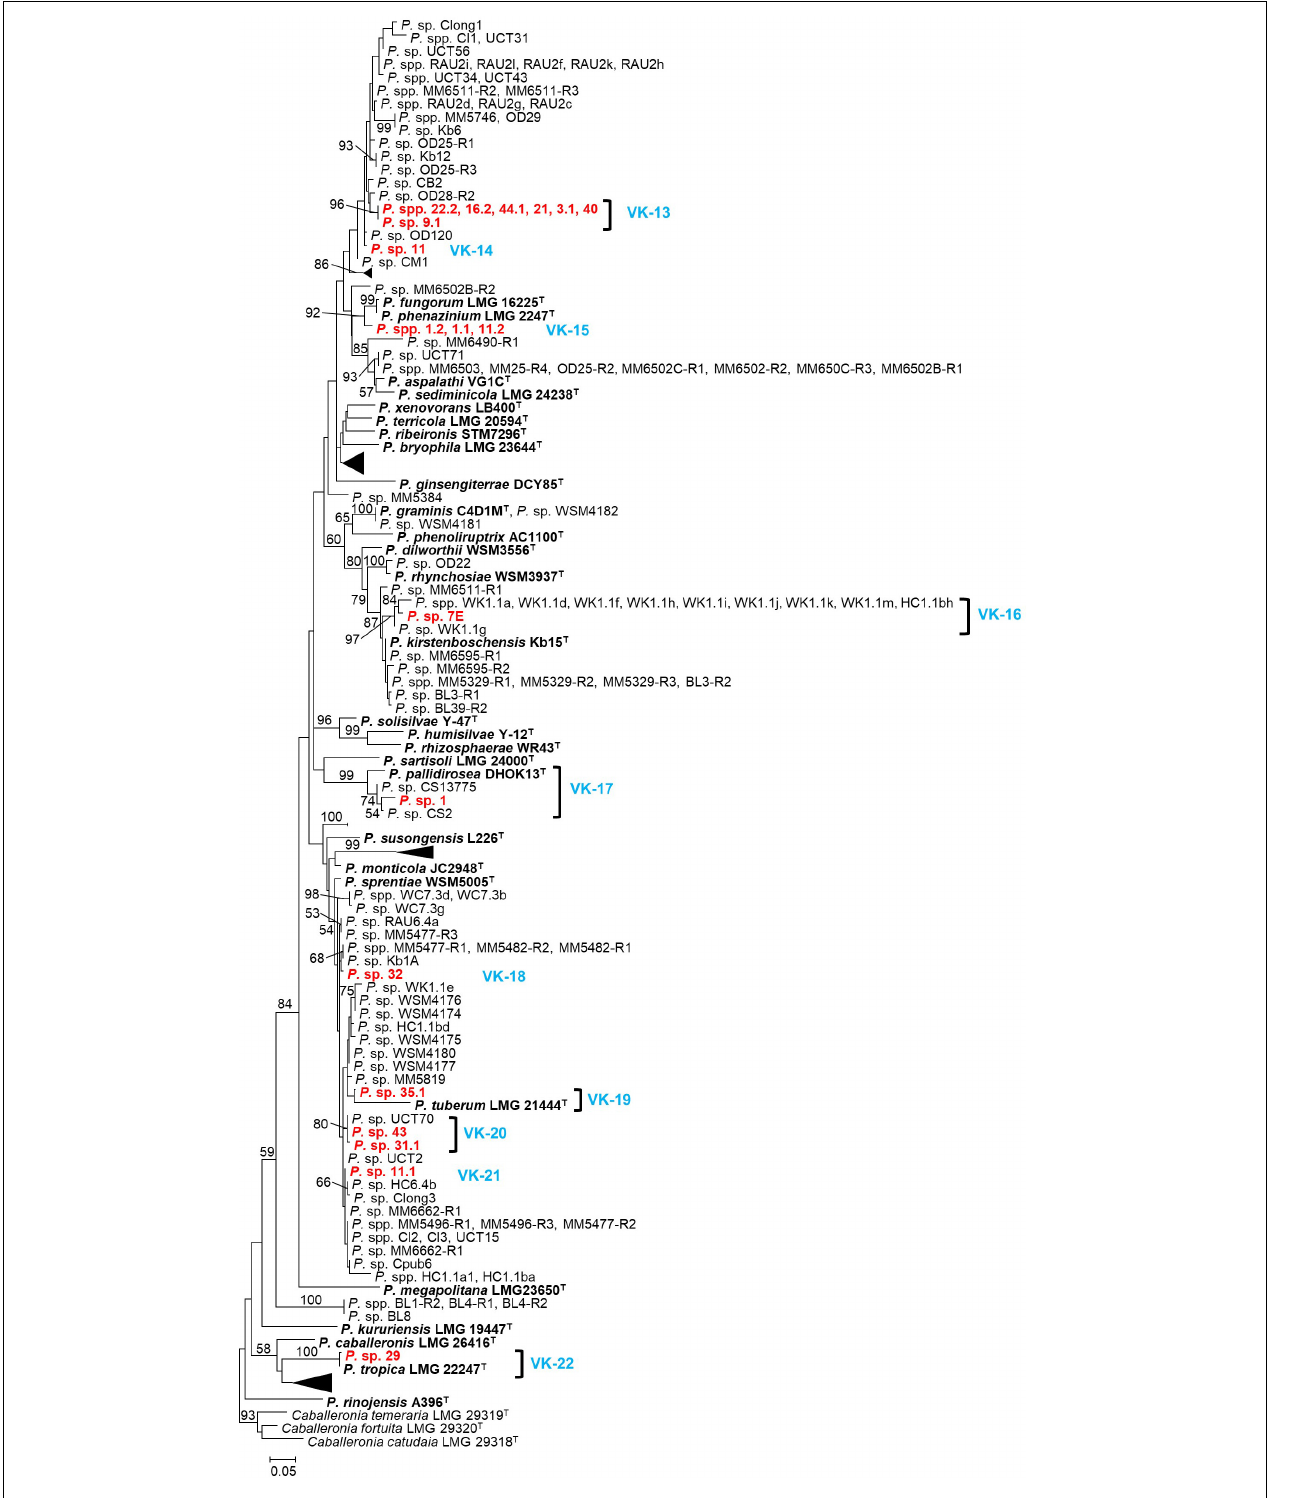
FIGURE 2 | A maximum-likelihood phylogeny of the recA locus for the beta-rhizobial genus Paraburkholderia . Isolates from this study are listed in red, while type strains of species appear in bold. The delineated Vachellia karroo -associated lineages (VK-13 to VK-22) appear in blue. In order to minimize the phylogeny some lineages (which do not contain any isolates from this study), have been collapsed. The expanded tree, containing information for the host or source and geographic origin of each isolate, appears as Supplementary Figure S3 . GenBank accession numbers for all the isolates included in this phylogeny are listed in Supplementary Table S3 . Nodes with ≥ 50% are indicated, while the scale bar shows the number of nucleotide substitutions per site.